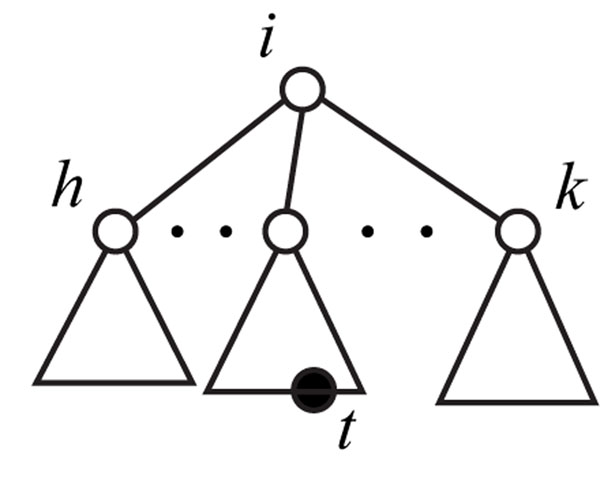
Example of ordered tree Ti,t,h,k